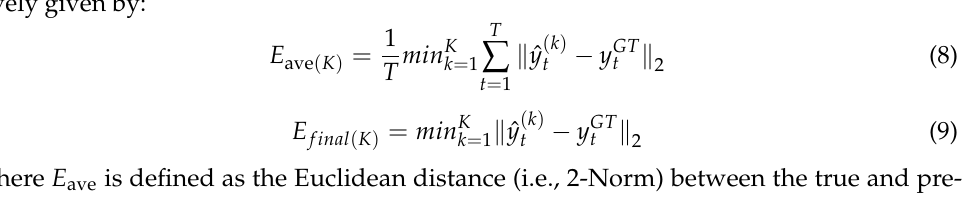
Figure 10. High ‐ definition semantic maps of the nuScenes dataset. ( a ) Singapore Queenstown; ( b ) Figure 10. High-definition semantic maps of the nuScenes dataset. ( a ) Singapore Queenstown; Boston Seaport; ( c ) Singapore One North; ( d ) Singapore Holland Village. ( b ) Boston Seaport; ( c ) Singapore One North; ( d ) Singapore Holland Village. E ave and E final for a sample of K trajectory predictions for the target SDV are